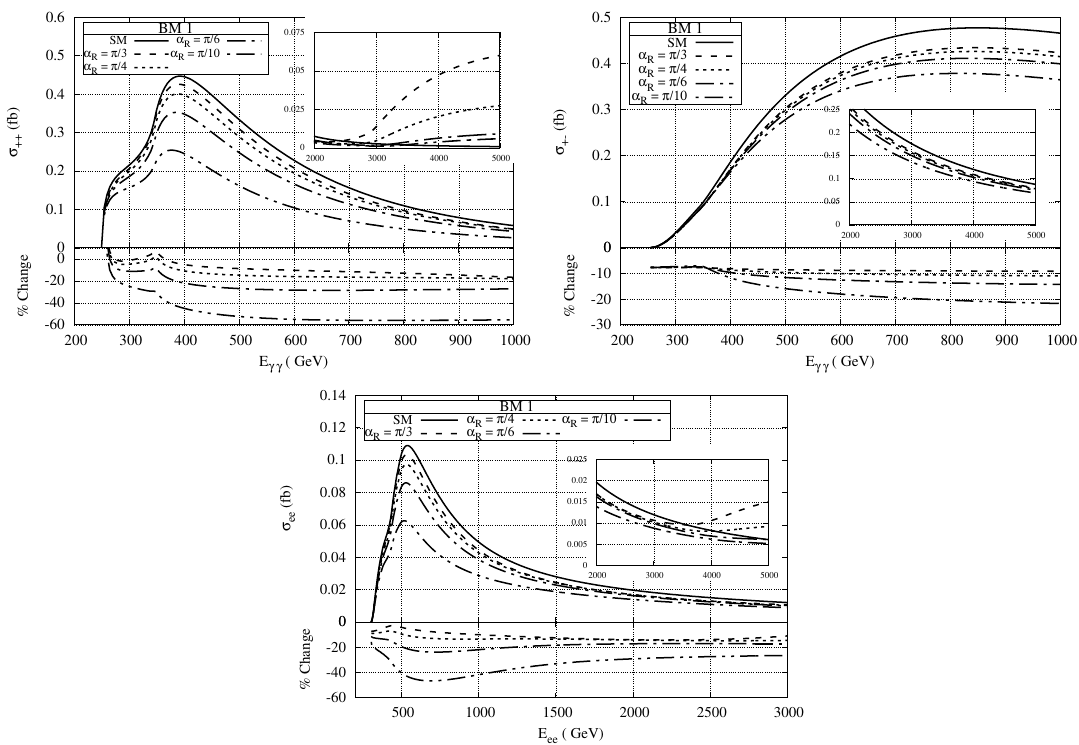
Figure 11 . γγ → hh cross-section for same photon helicities (top left panel), opposite photon helicities (top right panel) and e + e − → hh (bottom panel) in the model having an additional singlet top partner. The BM1 point parameters are given as Benchmark 1 in table